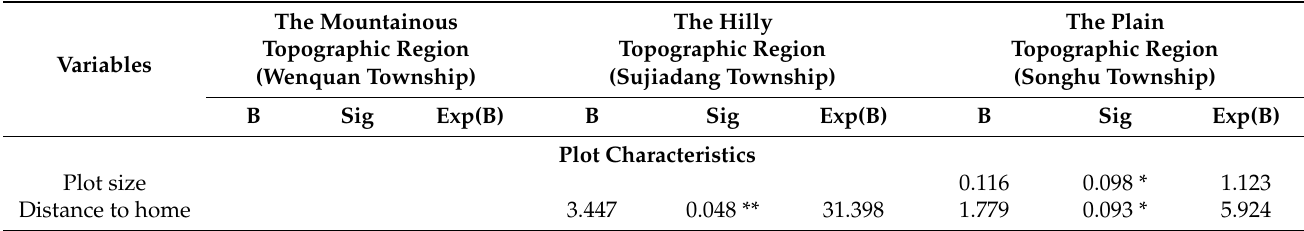
Table 9. Subsample results of pure households in three topographic regions.